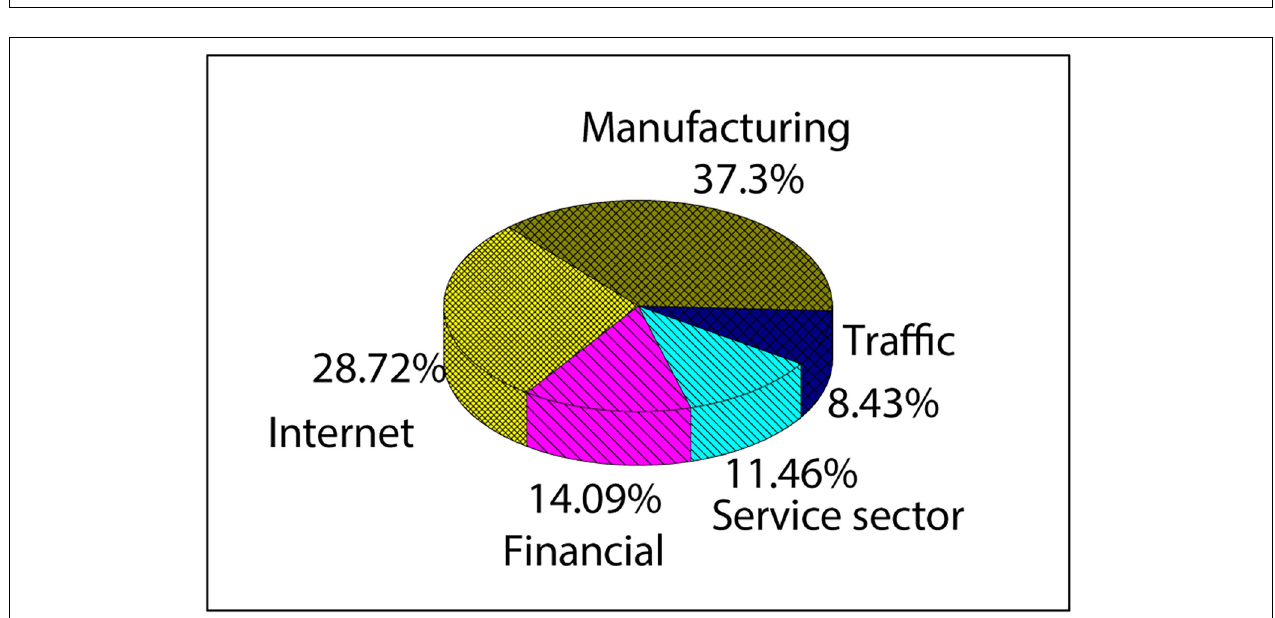
FIGURE 2 | Proportion of industry distribution of 399